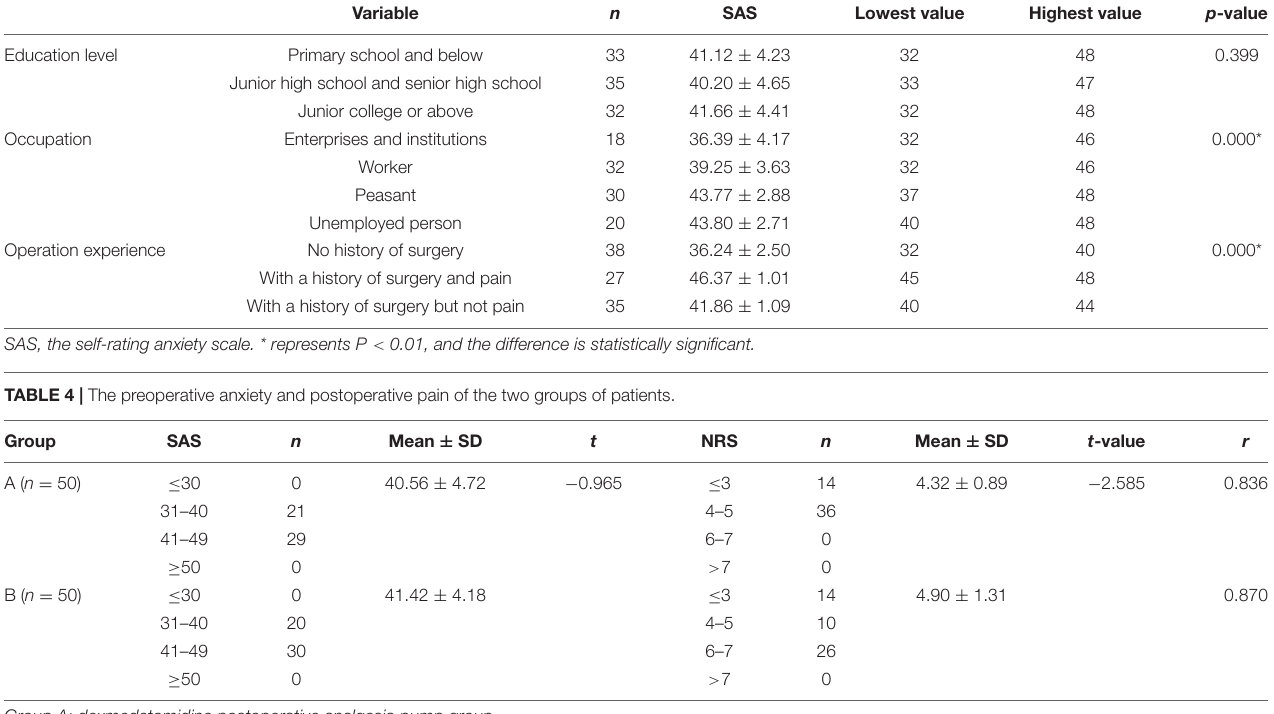
TABLE 3 | Univariate analysis of preoperative anxiety-related factors. Variable n SAS Lowest value Highest value